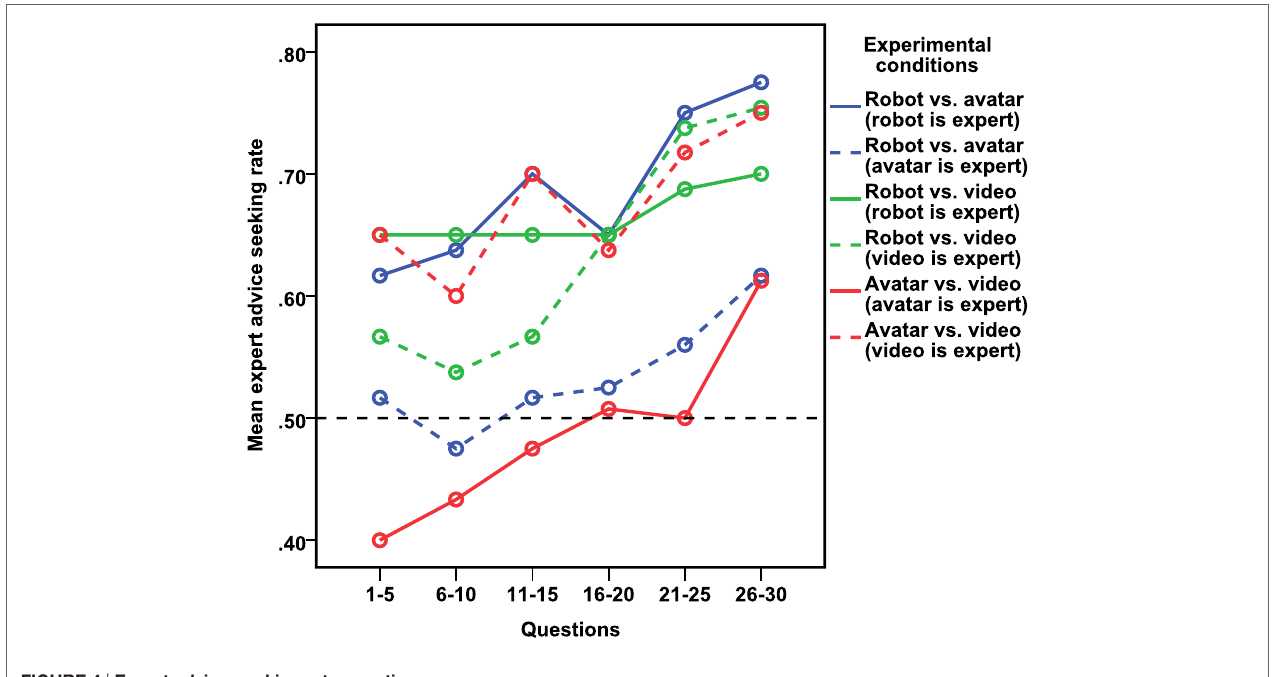
FigUre 4 | expert advice-seeking rate over time